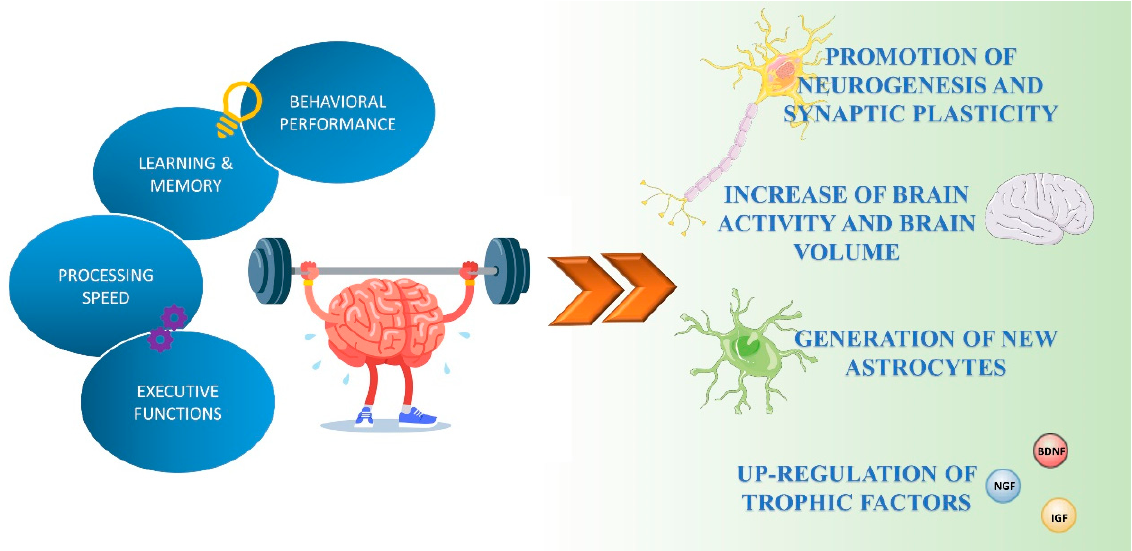
Figure 1. Exercise-mediated effects on brain functions. Exercise enhances cognitive performance by promoting neuronal plasticity, neurogenesis, and astrogenesis, and the production and release of neurotrophic factors.